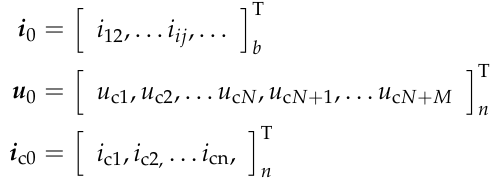
Figure 8. Equivalent circuit of a three-terminal MMC-based DC power